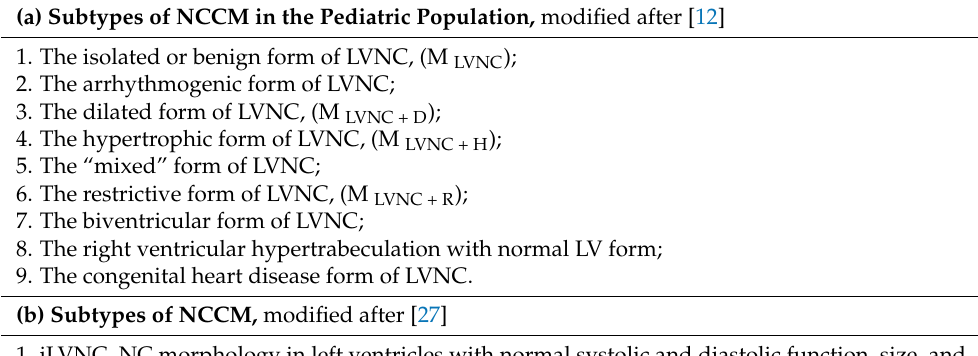
Table 2. Subtypes of noncompaction